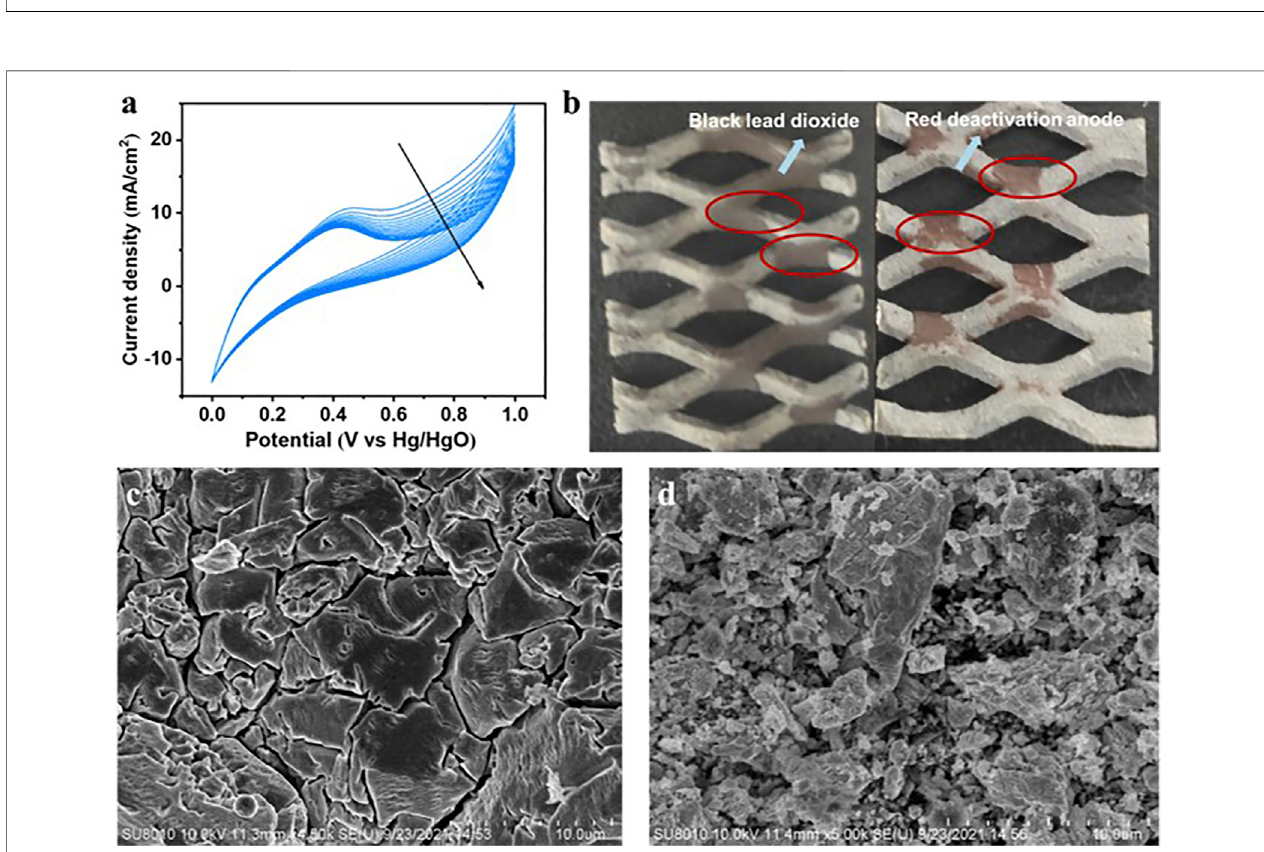
FIGURE6| Anodedeactivation: (A) CVcurvesoftheanodewiththeadditionofligninat40 ° C,withascanrateof5 mV/s,15cycles; (B) deactivationanodewiththe red substance on the electrode surface; (C) SEM image of normal Ti/PbO 2 anode; (D) SEM image of deactivated Ti/PbO 2 anode.